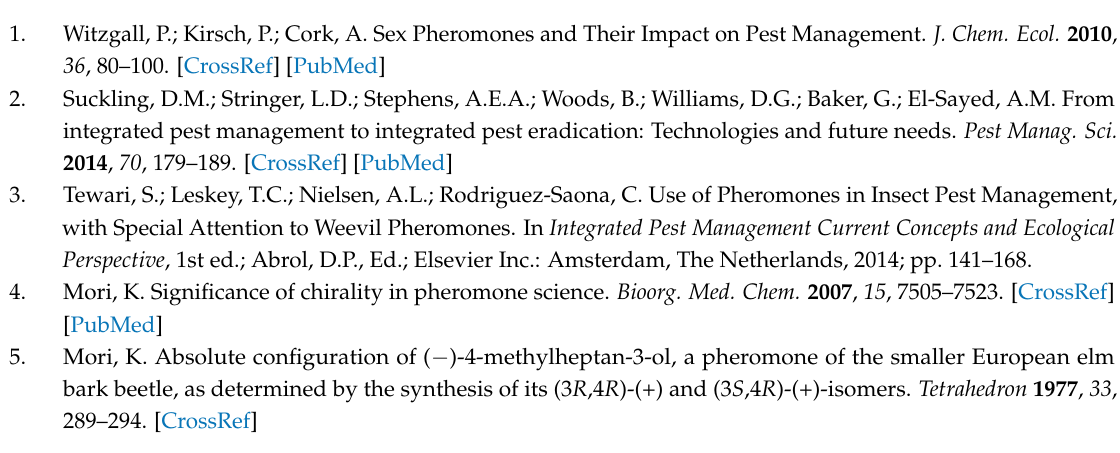
Supplementary Materials: The following are available online: synthesis and characterization of compound 2 , synthesis and characterization of compounds ( S ) and ( R )- 3 , general procedure for ER-mediated reduction of unsaturated ketone 2 (screening), general procedure for ADH-mediated reduction of racemic 3 (screening), representative GC chromatograms on chiral stationary phases, Table